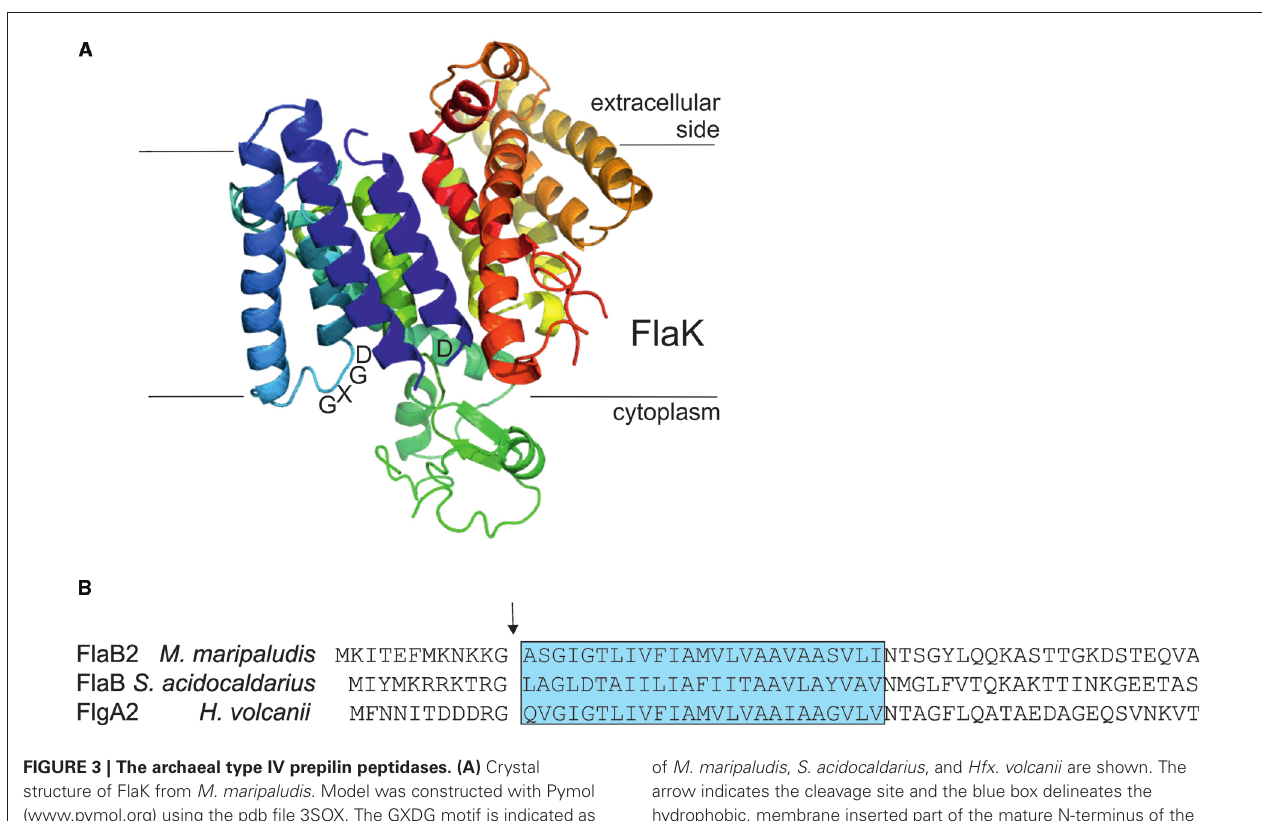
FIGURE 3 | The archaeal type IV prepilin peptidases. (A) Crystal structure of FlaK from M. maripaludis . Model was constructed with Pymol (www.pymol.org) using the pdb file 3SOX. The GXDG motif is indicated as well as the localization of the membrane. It is clear that the active site is directed toward the cytoplasmic side of the membrane where cleavage of the class III signal peptide occurs. (B) The N-terminal archaellin sequences